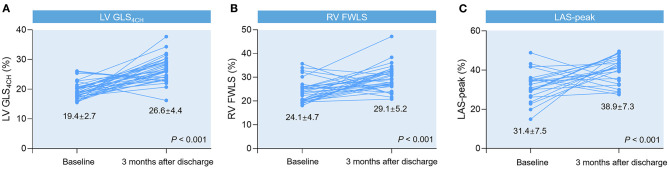
Spaghetti plots of LV GLS4CH
(A), RV FWLS (B), and LAS-peak (C) in patients with COVID-19 at 3-month follow-up after discharge compared with baseline values.